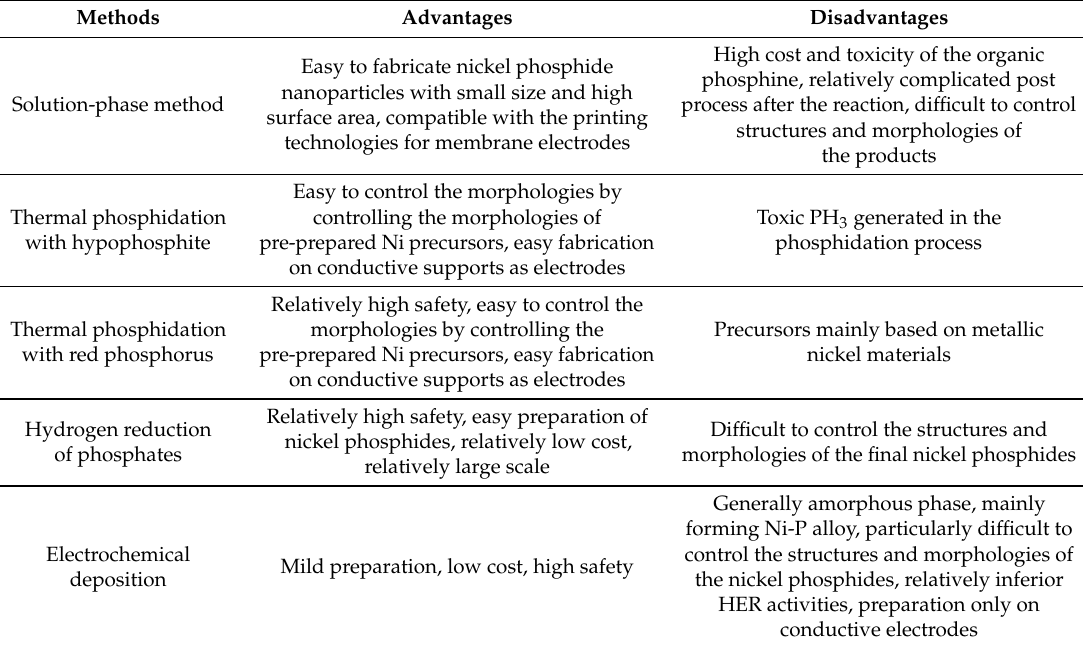
Table 9. Comparison of the preparation methods of nickel phosphide electrocatalysts for